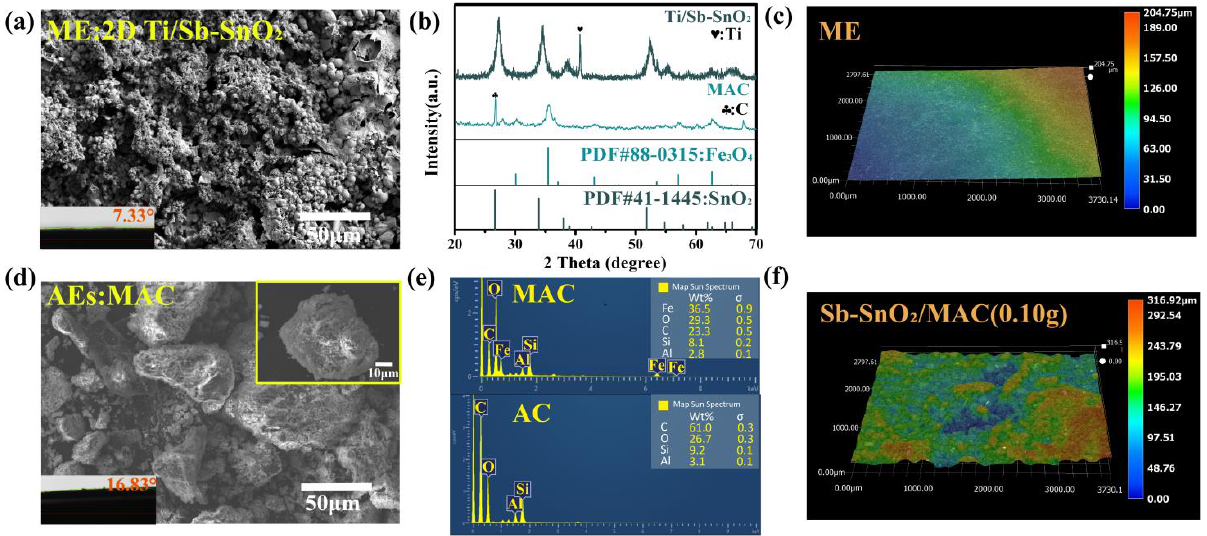
Figure 1. Material characterization results: ( a ) SEM image ( × 500) of ME (inset: water contact angle); ( b ) XRD of ME and AEs; ( c ) High depth of field micrograph of ME; ( d ) SEM image of ( × 500) of MAC (insets: SEM image of MAC ( × 1000) and water contact angle (very low angle, the numbers are just for reference)); ( e ) EDS element mappings of MAC and AC; ( f ) High depth of field micrograph of Sb-SnO 2 /MAC(0.10 g).